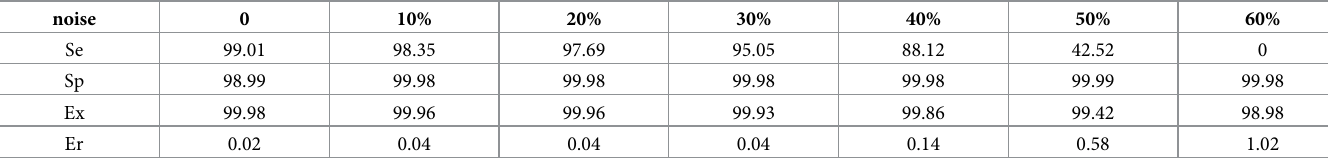
Table 5. Quadruple metrics under different mutation rates for integer coding [33] (%). noise